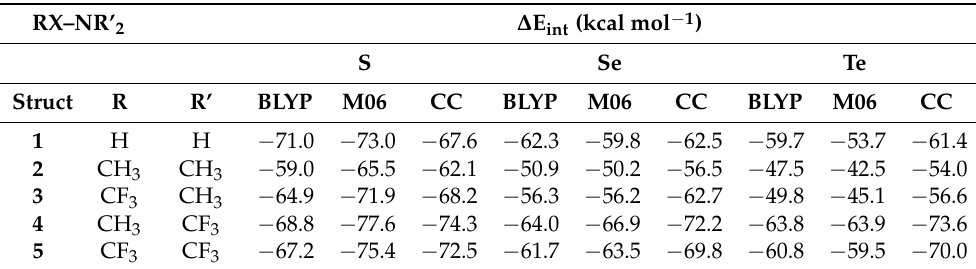
Table 3. The ∆ E int for the model molecules. Structure definitions are reported in Figure 1. Levels of theory: BLYP = ZORA-BLYP-D3(BJ)/QZ4P ae // ZORA-BLYP-D3(BJ)/TZ2P; M06 = ZORA-M06- 2X/QZ4Pae // ZORA-BLYP-D3(BJ)/TZ2P; CC = DLPNO-CCSD(T)/aug-cc-pVTZ-DK// ZORA- BLYP-D3(BJ)/TZ2P.